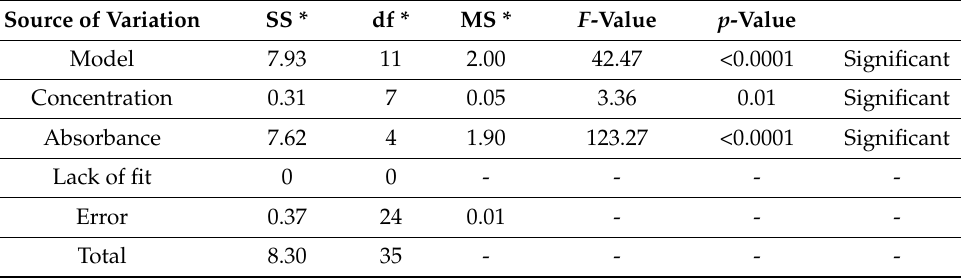
Table 9. ANOVA table of the minimum concentration for eradication of biofilm for MWCNTs_Ag on the investigated